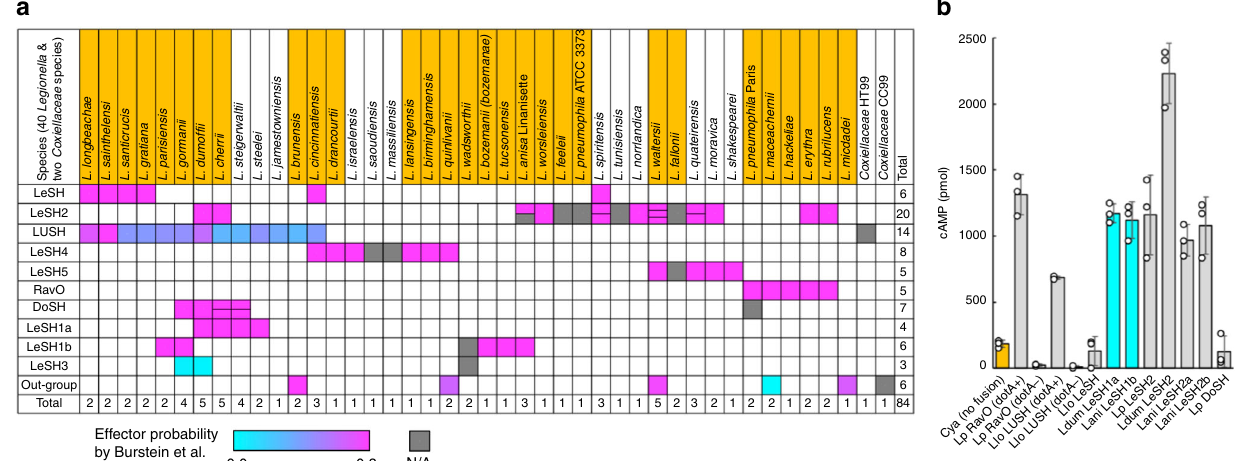
Fig. 2 Legionella SH2 proteins are translocated effectors. a Distribution of SH2 domain proteins in different Legionella species and their effector probability. Included in the heat map are 40 Legionella species (including two strains from L. pneumophila that contain distinct SH2 proteins) and two species from the Coxiellaceae family (that belongs to the order Legionellales ). The 28 Legionella species implicated in human disease are highlighted in yellow 2 . The effector prediction scores derived from Burstein et al. 13 were used to generate the heat map with a cyan-to-magenta gradient representing low-to-high effector probability for the 71 proteins listed in Burstein et al. 13 . The scores are not available (N/A) for 13 other SH2 proteins and they are colored gray. When LeSH2 or DoSH paralogs exist for a species, the cell is divided accordingly into two or three sections. For example, L. waltersii encodes three paralogs of LeSH2 all with high effector potential. See Supplementary Table 1 for a full list of the SH2 proteins. b Type IV secretion system (T4SS)-dependent translocation of Legionella SH2 proteins from bacteria to host cells. Ten SH2 proteins from Legionella fused with the adenylate cyclase Cya were expressed in the L. pneumophila strain Lp02 (dotA + ). The L. pneumophila RavO and L. longbeachae LUSH were also tested in the Lp03 strain (defect in the T4SS, or dotA − ). Differentiated U937 cells were infected with bacteria expressing the different Cya-fusion protein. Translocation of the fusion proteins was monitored by the intracellular cyclic AMP (cAMP) level, which is an indicator of the Cya activity in eukaryotic host cells. The error bars indicate standard deviation from triplicate infection experiments. See Supplementary Fig. 5 for expression level of the Cya-fusion proteins and p -values that indicate statistical signi fi cance of translocation of the Cya-fusion proteins in comparison to the Cya itself (labeled no fusion ). The cAMP values are derived from Supplementary Fig. 5a, except for L. dumof fi i LeSH1a and LeSH2, which are taken from Supplementary Fig. 5b. L. dumof fi i LeSH1a and L. anisa LeSH1b, which are de fi cient in pTyr binding (see Fig. 3c), are colored